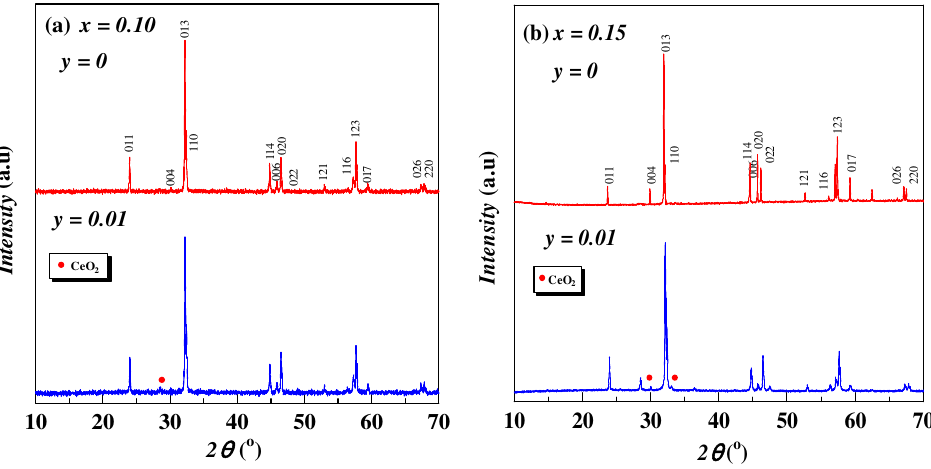
Figure 1. The XRD pattern of Eu 2− x Ce x Cu 1− y Zn y O 4+ α − δ with x = 0.10 ( a ) and 0.15 ( b ).